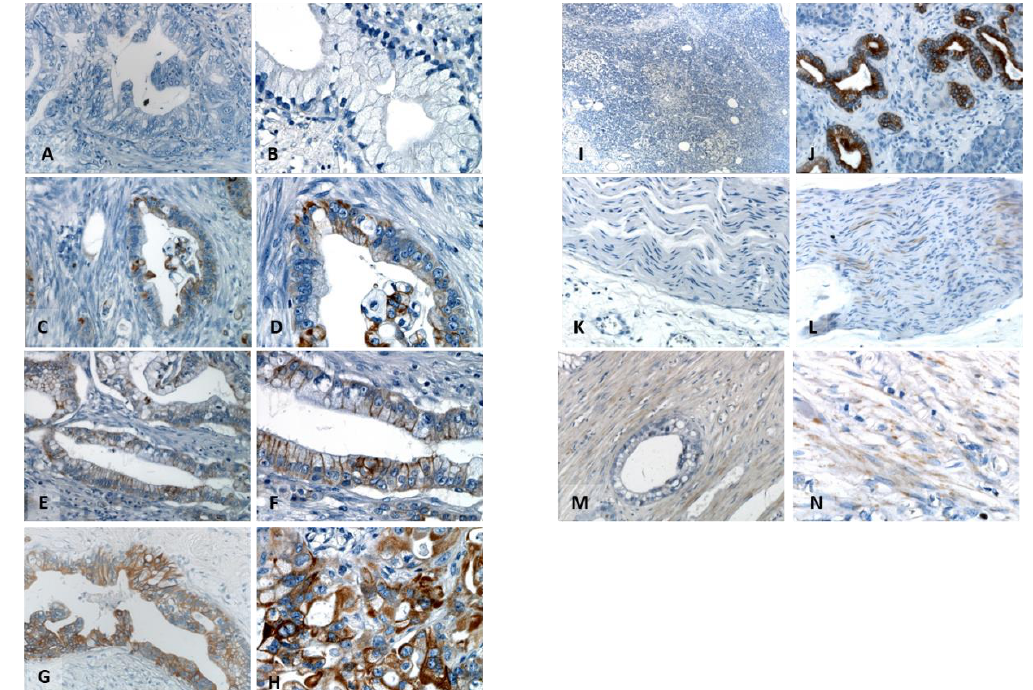
Figure 3. PDAC Cancer cells express CXCL12. Representative expression in PDAC (left panel 200× and 400× magnification). CXCL12 negative ( A , B ). CXCL12 low expression, featured mainly by membrane and cytoplasmic staining ( C , D ). CXCL12 moderate expression, featured by mild diffusion of membrane and cytoplasmic staining ( E , F ). CXCL12 high expression, featured by massive diffusion of membrane and cytoplasmic staining ( G , H ). TME analysis (right panel): Representative CXCL12- negative sample (50×) ( I ), with strong positive signal in TME exocrine pancreatic ductal cells adjacent PDAC (100× magnification) ( J ). No ( K ) or faint ( L ) staining in the nerve (200× magnification), CXCL12 expression was reported in fibrotic tissue (M, N ).